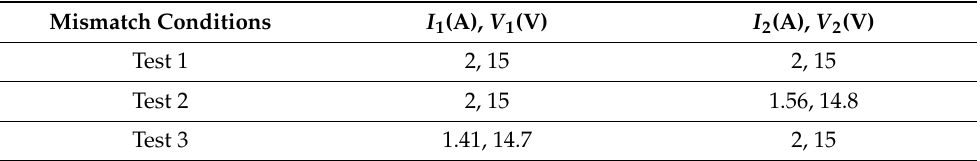
Table 5. Mismatch condition for the experiment.